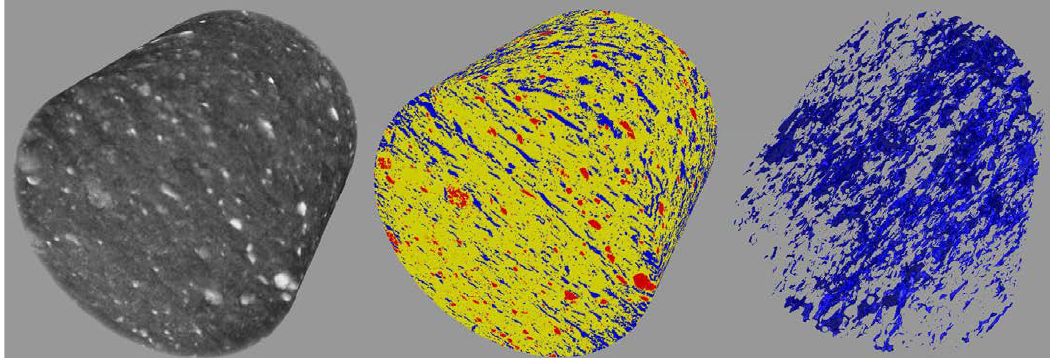
Figure 2. The cylindrical ROI of one of the samples from ceramic 4, viewed from one end ( left ); the same ROI segmented with a deep learning model based on sensor 3D architecture to separate pores (marked as blue here) from silica-rich particles (marked as red) and ceramic matrix (marked as yellow) ( center ); and an ROI with only pores (18.7 vol.%) visible ( right ).